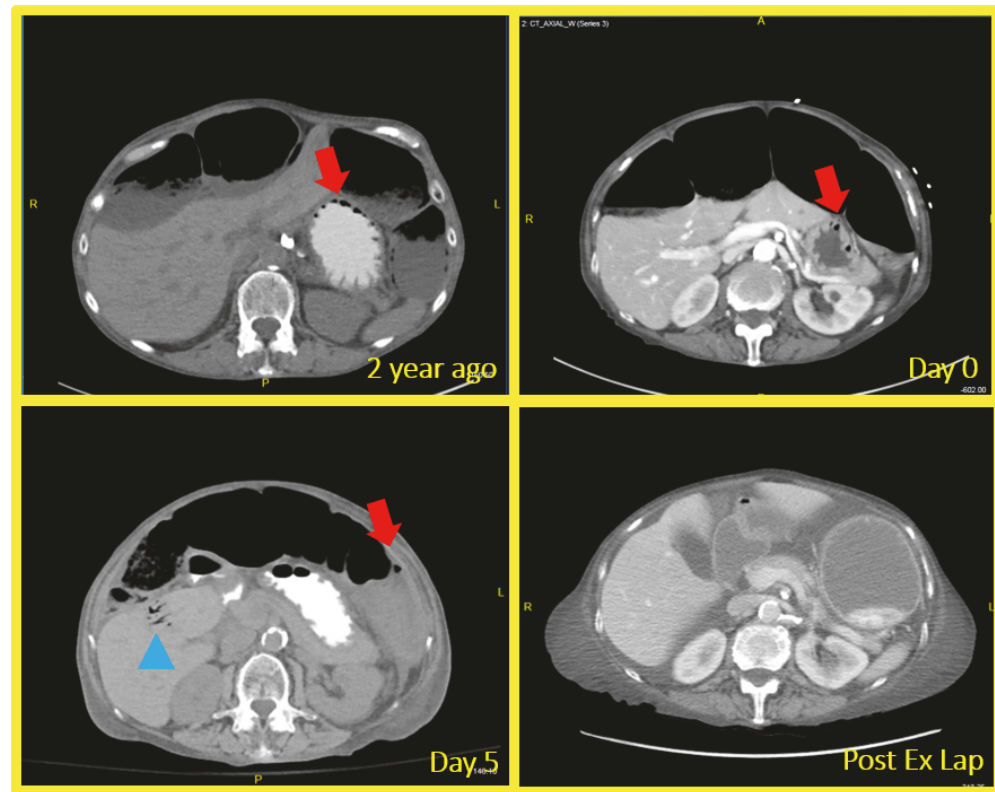
Figure 1: CT of abdomen revealed chronic bowel dilation and pneumatosis intestinalis ((a) and (b)); emergency of portal vein gas and worsening pneumatosis intestinalis (c); improvement after subtotal colectomy (d). Red arrow: pneumatosis intestinalis; blue arrow: portal vein